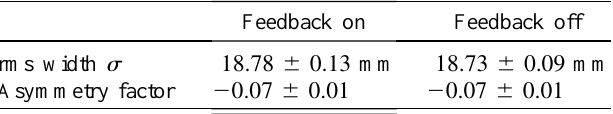
TABLE IX. The electron bunch length and asymmetry factor when the instability is present (feedback off) and not present (feedback on).